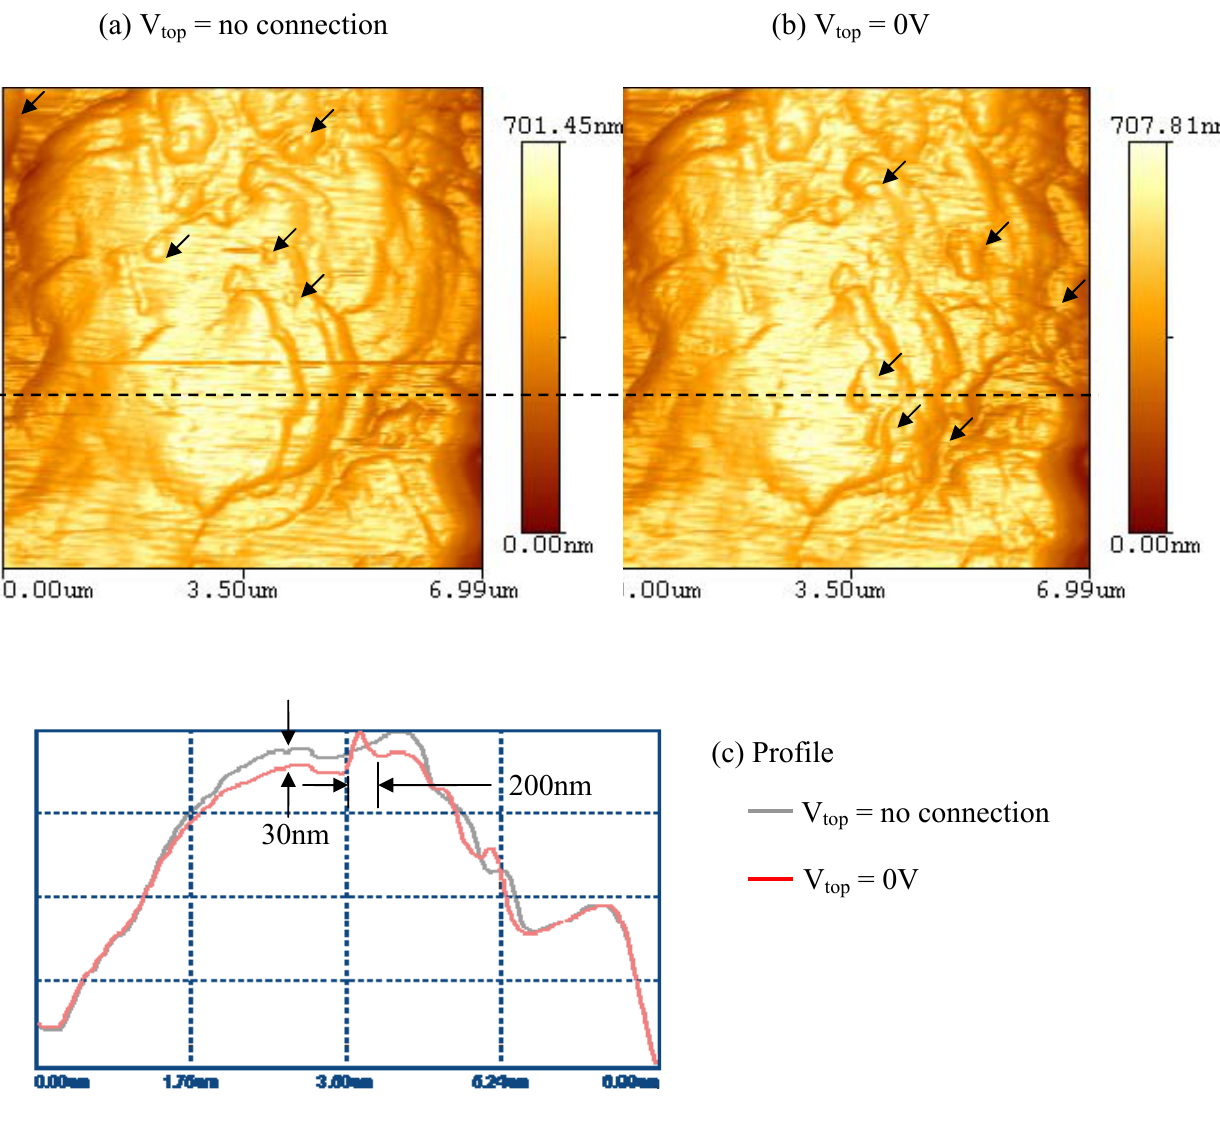
Figure 3. AFM images for the PVDF sample surface which was 110µm thick with 28µm Ag coated without (a) or with (b) connection of electric field. (c) The profiles of the two scans along the dashed